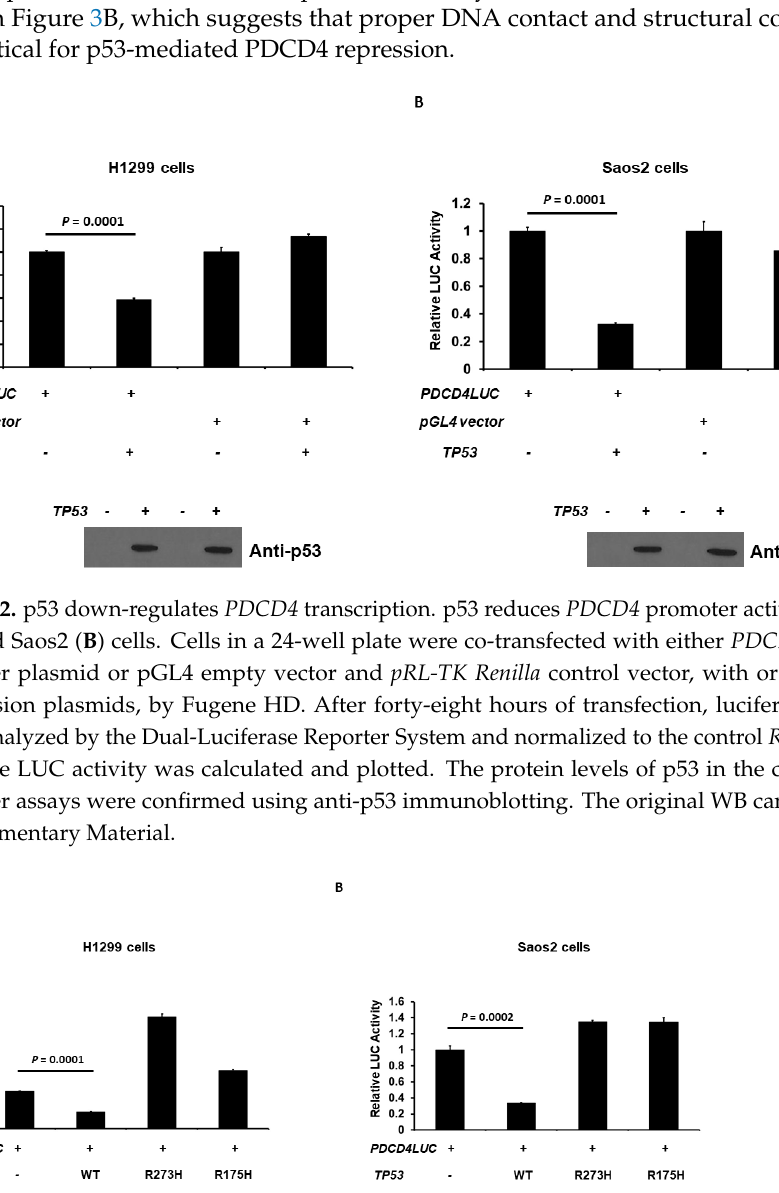
Figure 3. Hot-spot mutations on p53 abolish p53’s ability to down-regulate PDCD4 transcription. H1299 ( A ) and Saos2 ( B ) cells in a 24-well plate were co-transfected with the PDCD4 luciferase reporter plasmid and pRL-TK Renilla control vector and either WT, R273H, or R175H p53 expression plasmids by Fugene HD. After forty-eight hours of transfection, luciferase activities were analyzed by the Dual-Luciferase Reporter System and normalized to the control Renilla activity. Relative LUC activity was calculated and